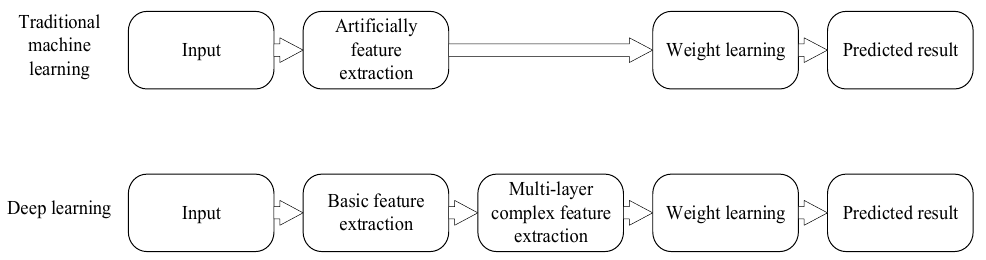
Figure 1. Difference between deep learning and the traditional machine learning process. Deep neural networks (NNs) have also become useful when there is no supervision of learning. Among ANNs, both feedforward neural networks (FNNs) and recurrent (cyclic) neural networks (RNNs) have been used mainly in research. Recurrent neural networks (RNNs), in theory, can approximate arbitrary dynamical systems with arbitrary precision comparable to other traditional ANNs. However, RNNs are different from